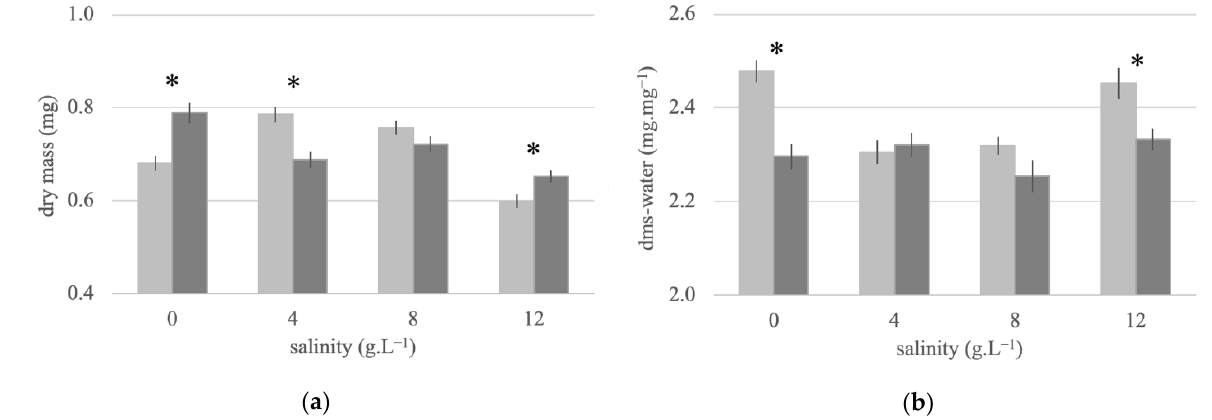
Figure 4. Body characteristics of newly emerged female mosquitoes from insecticide-susceptible (Vs) and -resistant (Vr) A. aegypti strains reared at different salinities. ( a ) Dry mass and ( b ) dry mass-specific water content. Light grey columns represent Vs adult females, and dark grey columns represent Vr adult females. Bars represent S.E.M. Significant differences between the strains within each salinity group are represented by an asterisk.